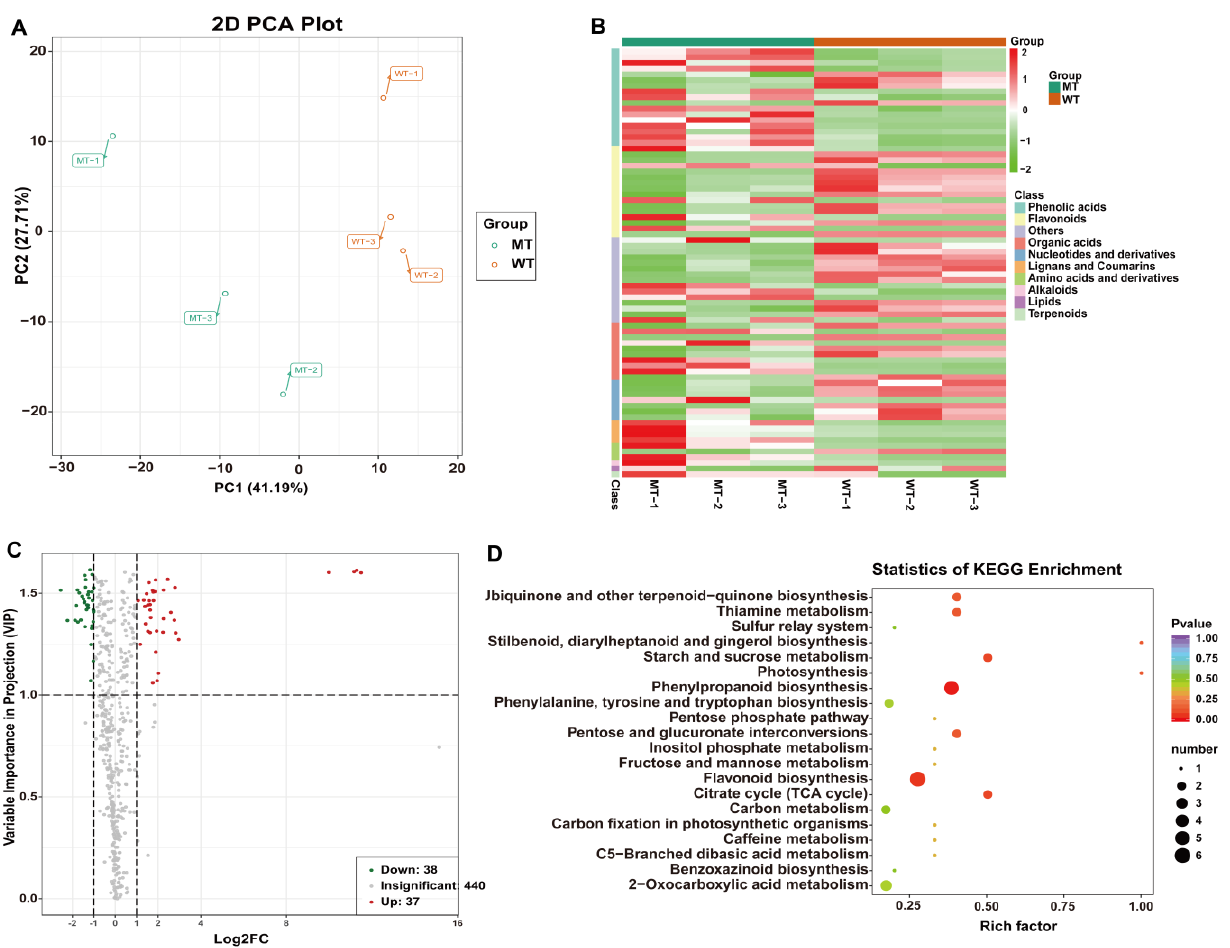
Figure 6. KEGG classification statistics and enrichment analysis of DAMs in MT vs. WT. ( A ) MT VS WT opls score: in the x-coordinate, P1 represents the predicted principal component and O1 represents the orthogonal principal component; ( B ) KEGG classification statistics of DAMs in MT vs. WT; ( C ) Differential metabolite volcano map; ( D ) Scatter plot of DAMs enriched KEGG pathways. Rich factor is the ratio of the DAM number to the background number in a certain pathway. The size of the dots represents the number of metabolites, and the color of the dots represents the range of the p -value.